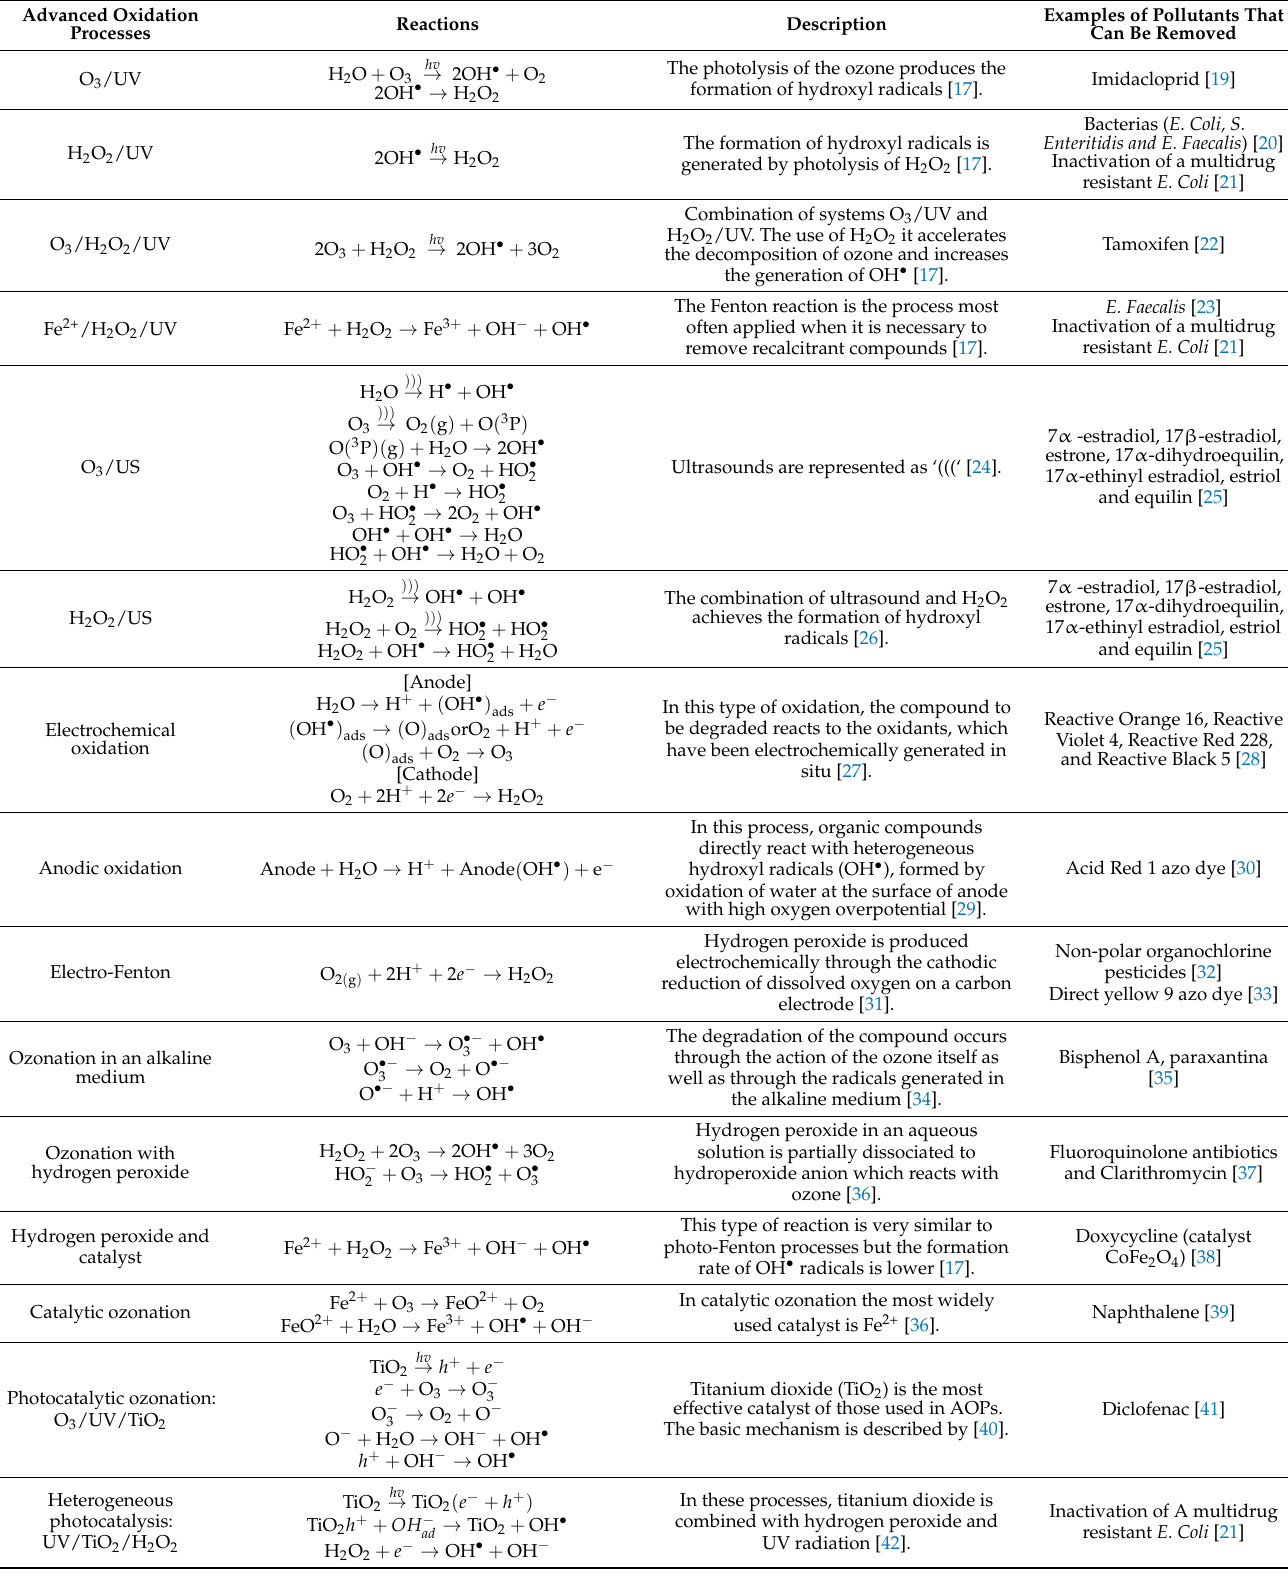
Table 1. Reactions of the different types of advanced oxidation